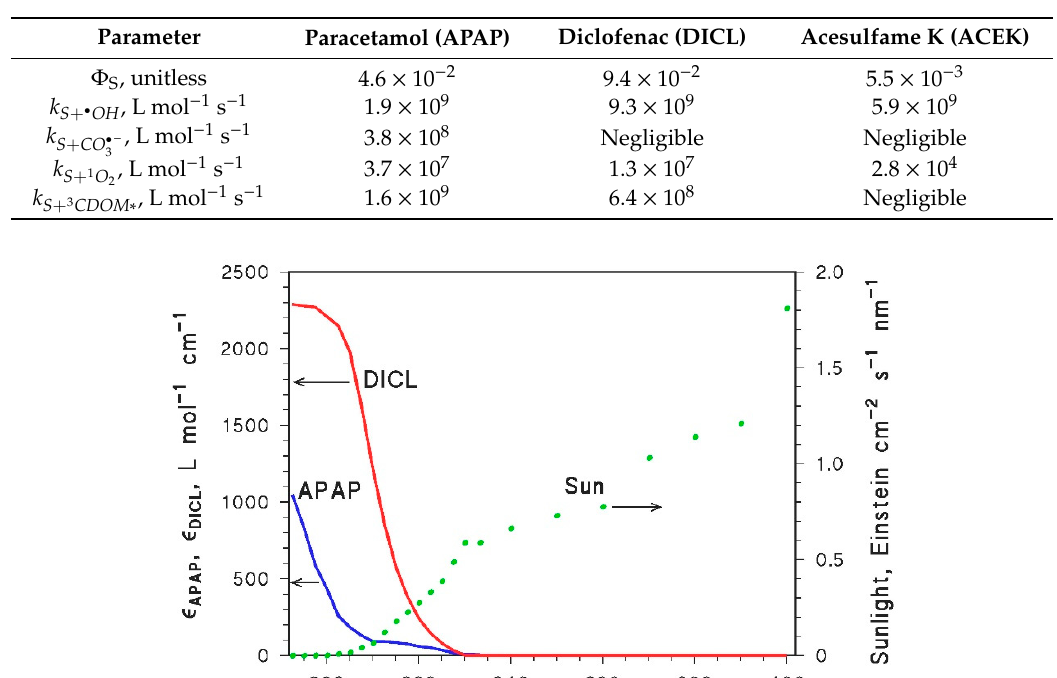
Table 1. Photoreactivity parameters of paracetamol (S = APAP), diclofenac (S = DICL), and acesulfame K (S = ACEK). Note that Φ is the symbol for the direct photolysis quantum yield.